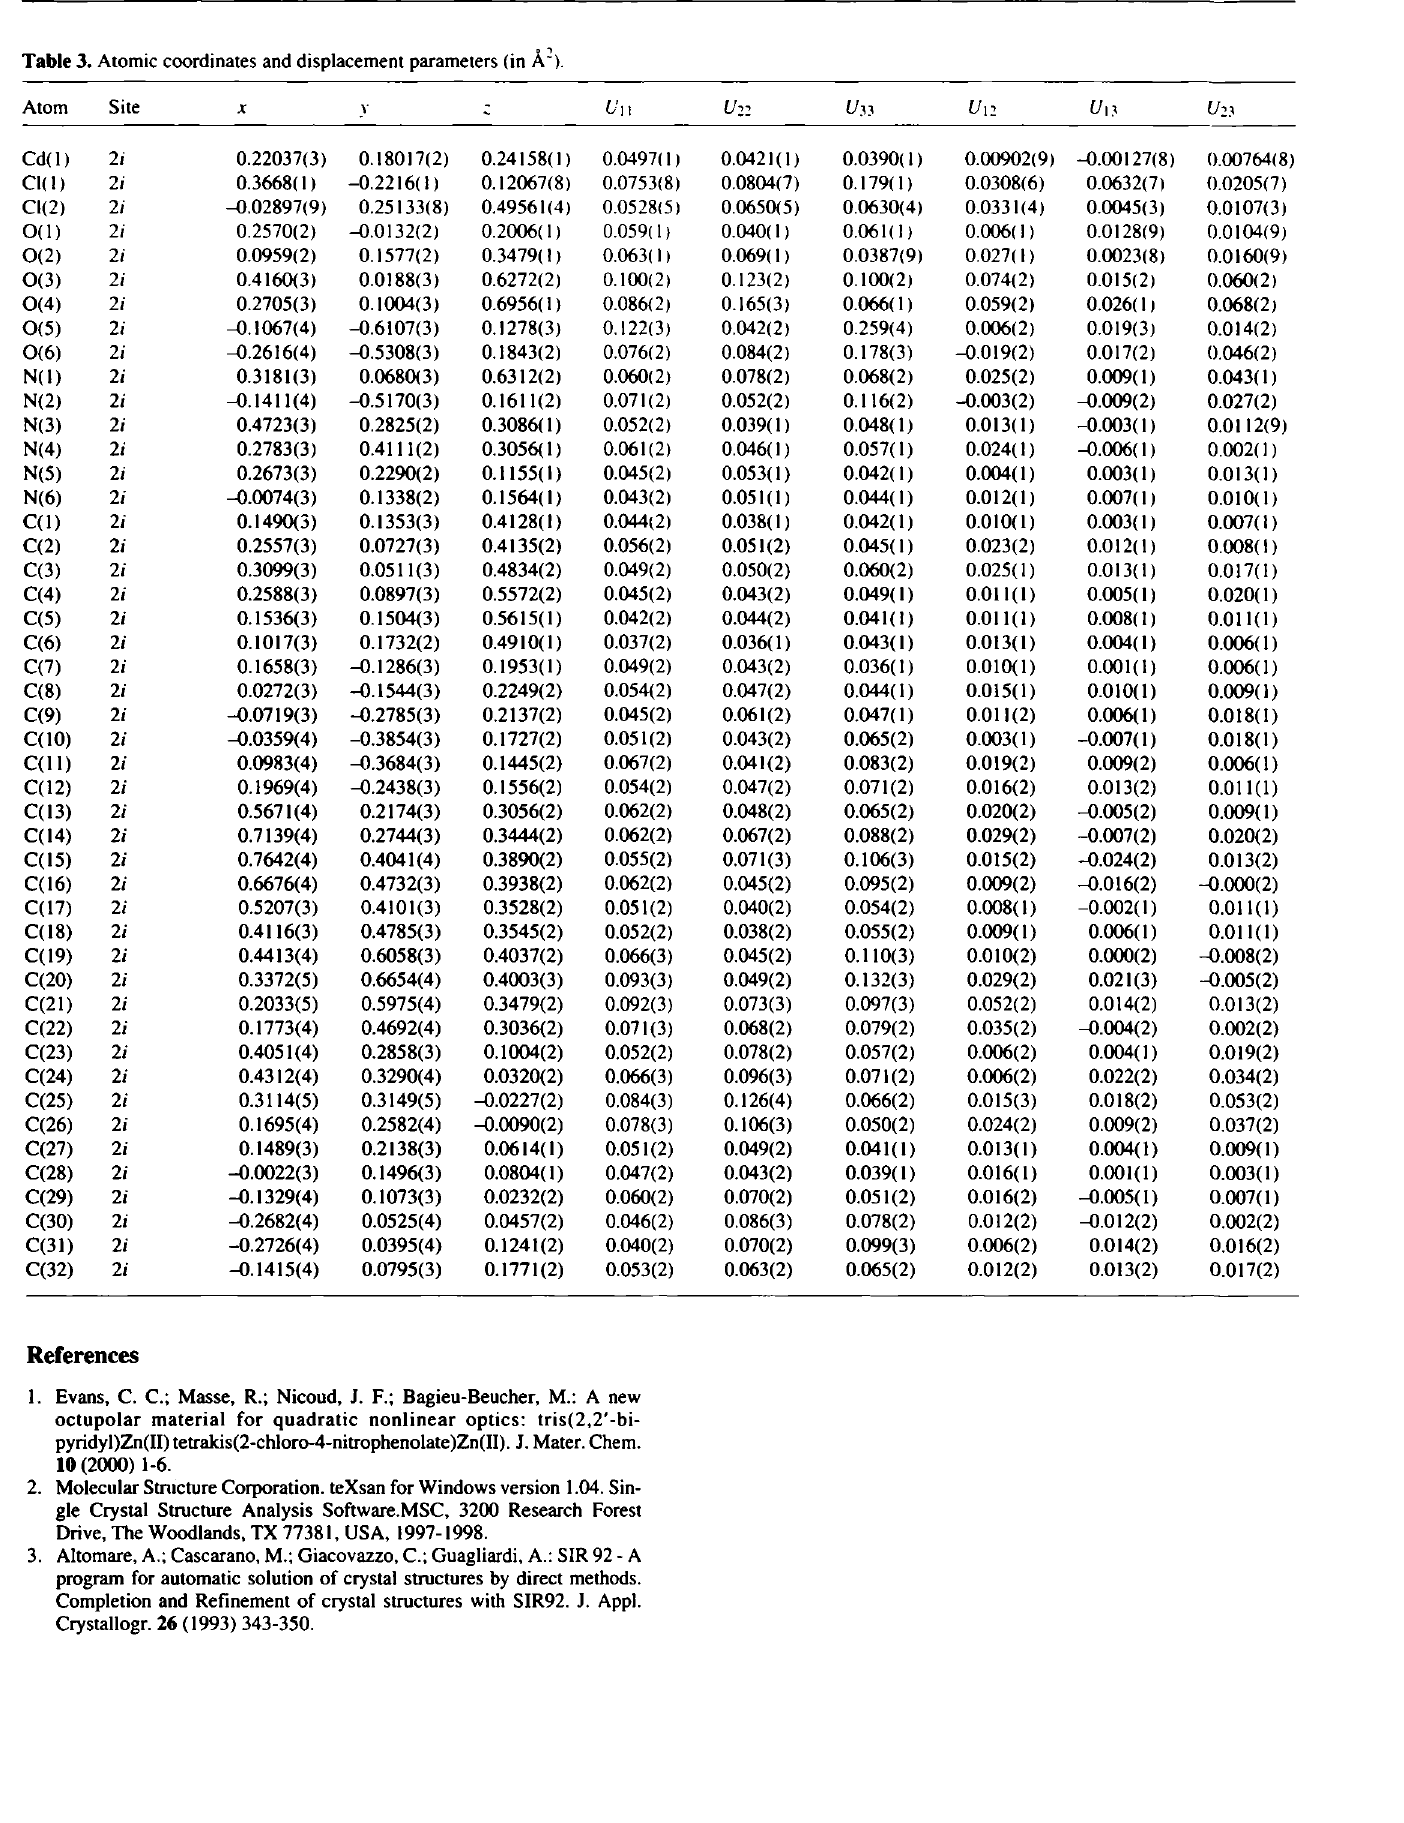
Table 3. Atomic coordinates and displacement parameters (in